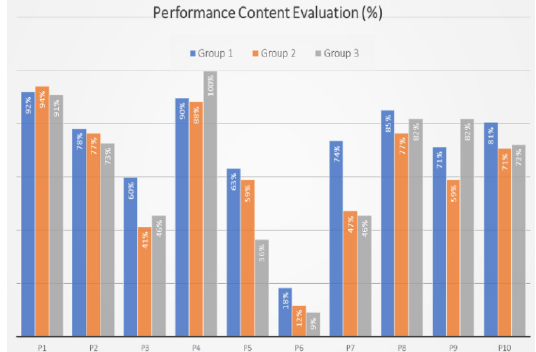
Fig. 14. Students’ performance in the evaluation of laboratory contents. Group 1: students who studied physics i under the virtual modality. Group 2: students who studied physics I taking advantage of the new laboratory equipment acquired. Group 3: students who studied physics I under the classroom modality, but who did not have the new equipment